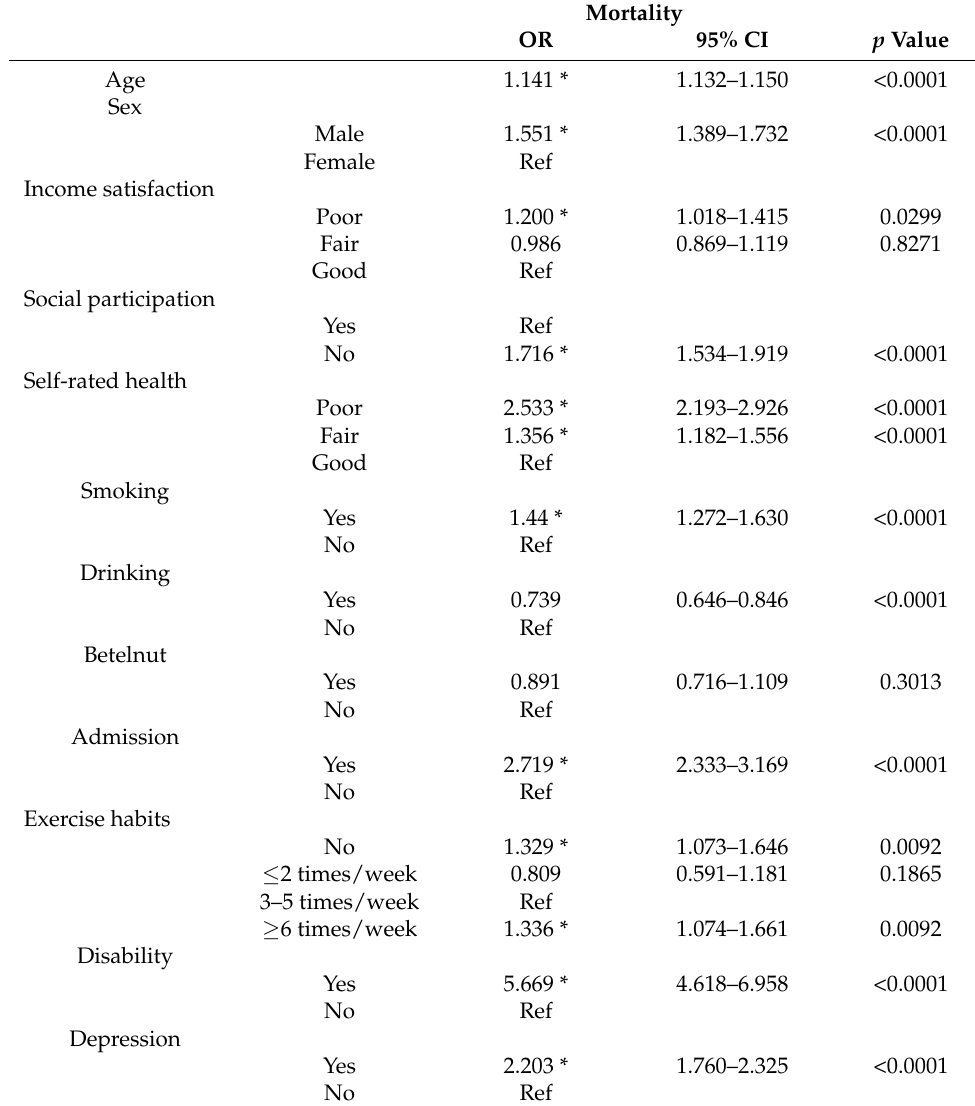
Table 2. Univariate logistic regression analysis of demographic and clinical characteristics predicting